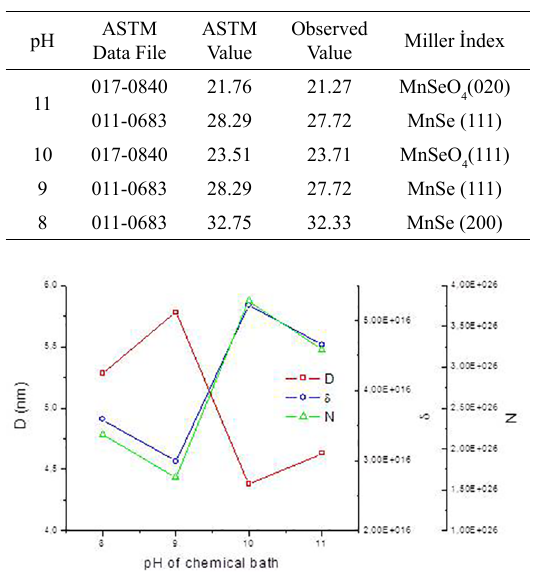
Figure 2. The grain size (D), dislocation density (δ), and number of crystallites per unit area (N) values of MnSe thin films at different